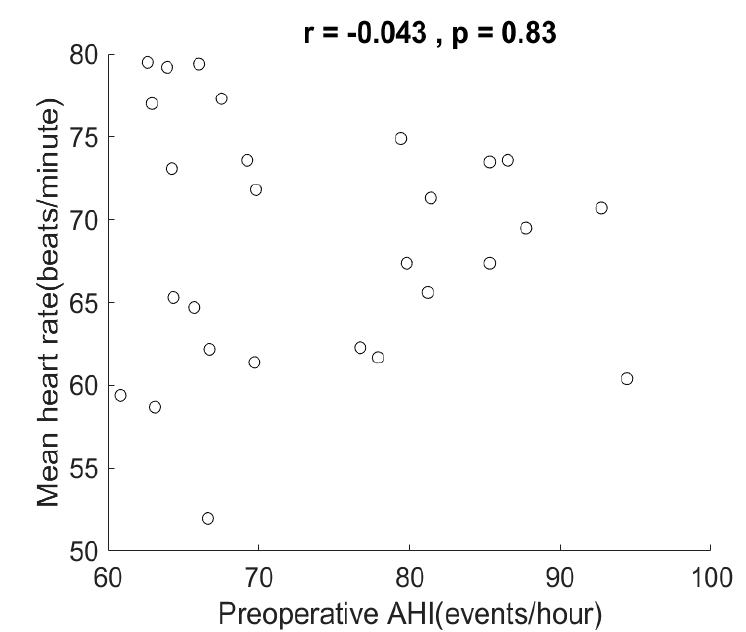
Figure 2. Scatter plot and correlation of preoperative AHI vs. mean heart rate. This shows that preoperative mean heart rate was not related to AHI in the very severe obstructive sleep apnea (OSA) patients in this study.